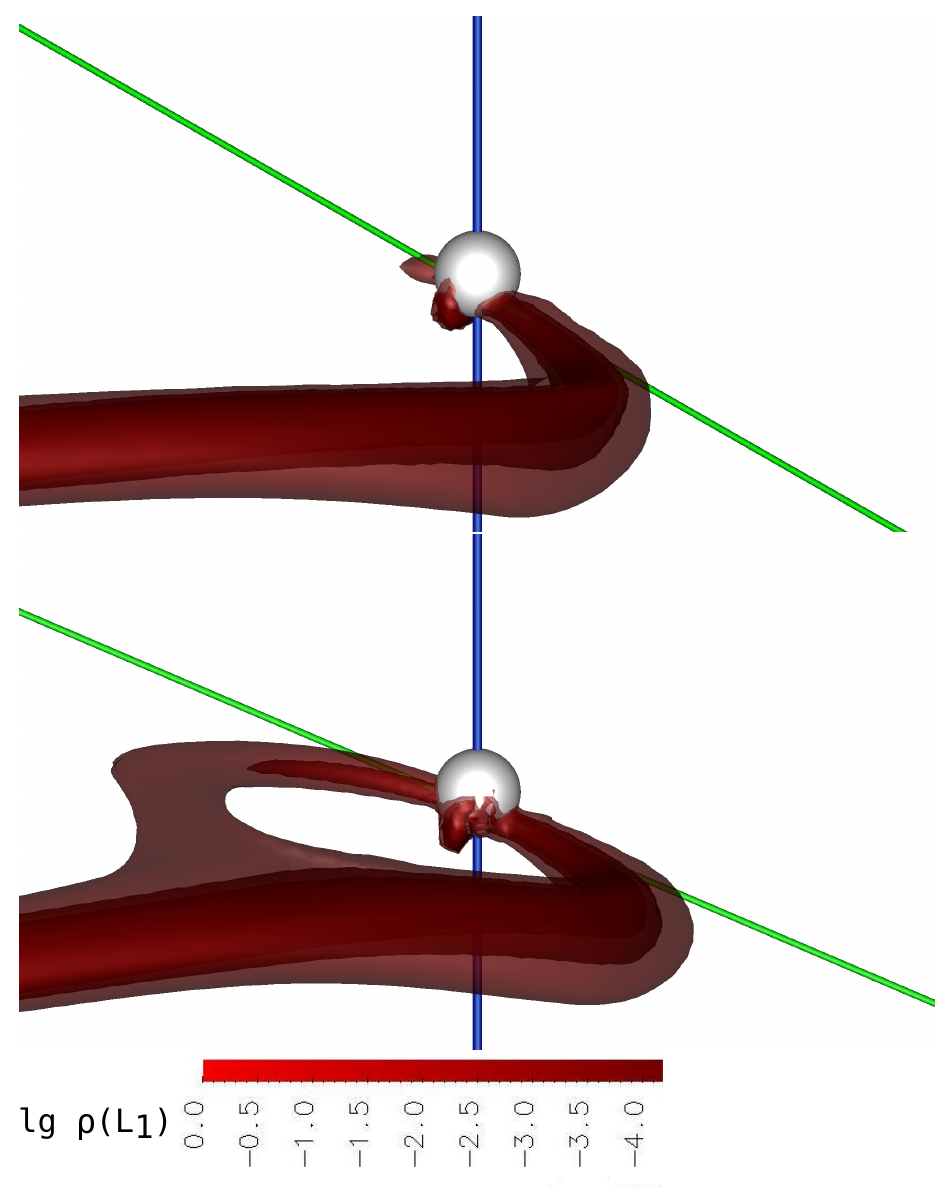
Figure 10. The three-dimensional numerical modeling results of the matter flow structure in the asynchronous polar with an offset dipole for the moment of switching from the south magnetic pole to the north one. The iso-surfaces of the decimal logarithm of the density are shown in units of ρ ( L 1 ) . The surface of the accretor is presented as a white sphere. The binary system is at the orbital phase 0.9. The upper panel coincides with Phase 1, and the lower panel with Phase 2 of the switching